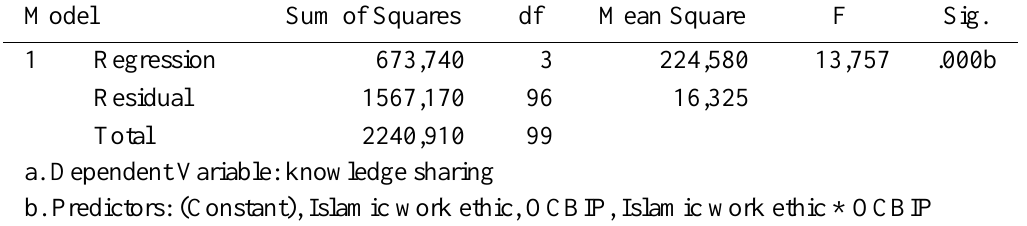
Interaction Test Results Modereted Regression Analysis (Model